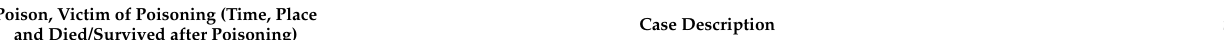
Table 2. Description of political criminal poisonings in the years